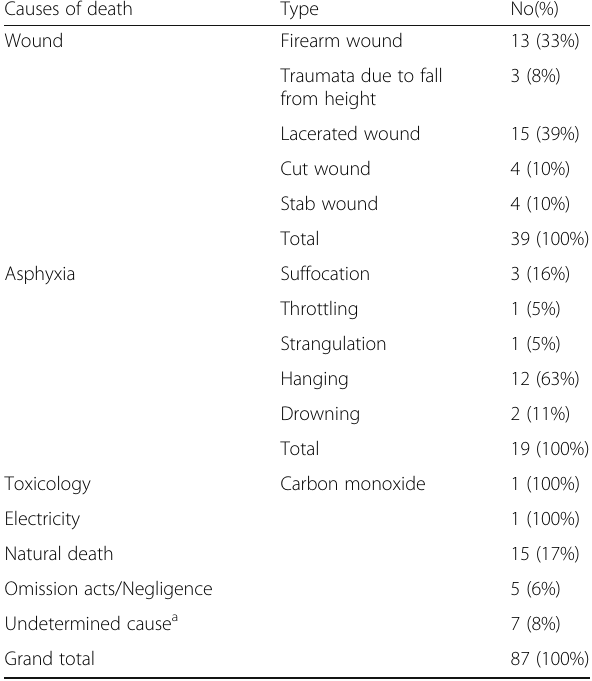
Table 2 Causes of death ’ distribution among studied child victims Causes of